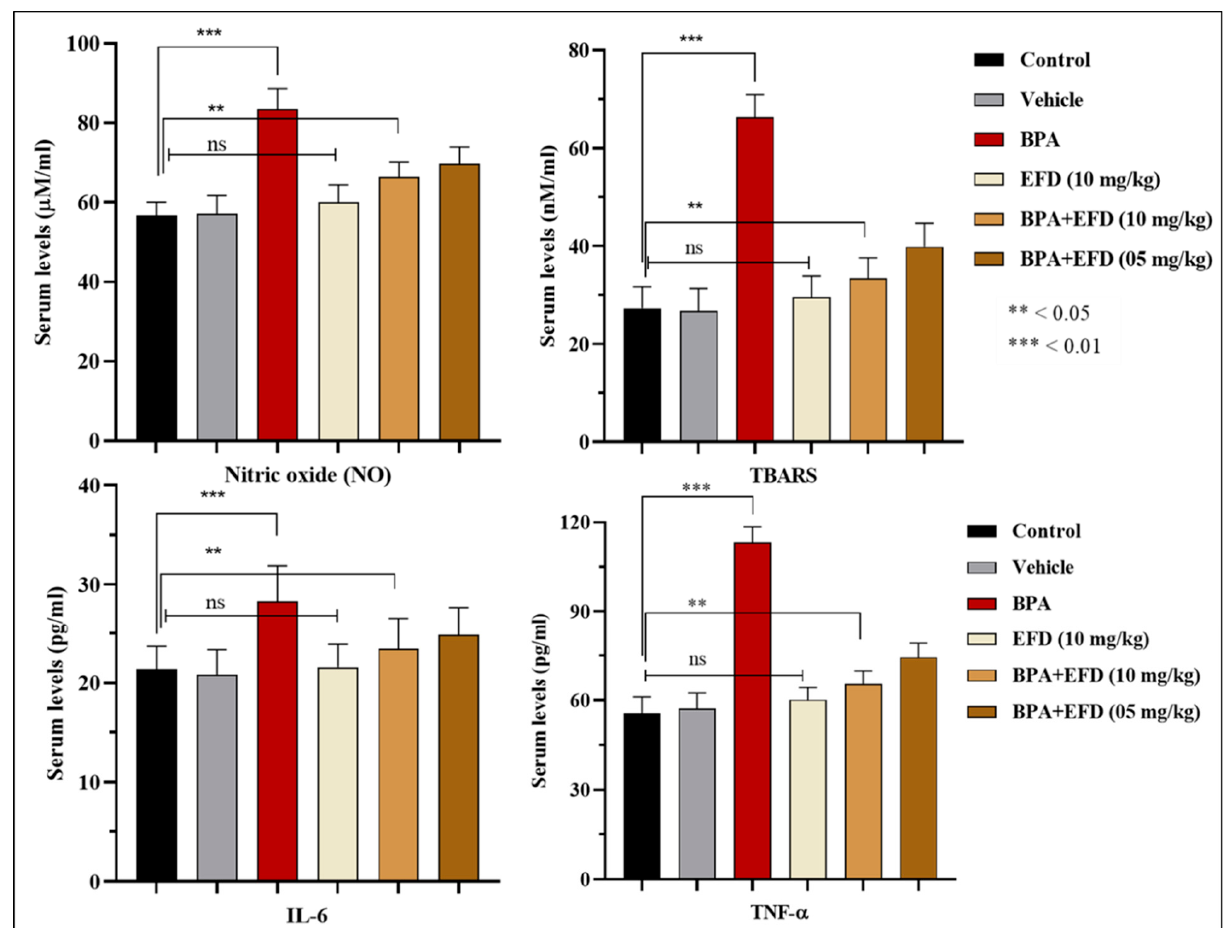
Figure 6. Fate of pro-inflammatory markers in experimental animals after co-treatment with EFD (05 and 10 mg/kg). (NO) Nitric oxide, (TBARS) Thiobarbituric acid reducing substances (Lipid peroxidation assay), (IL-6) Interleukin-6, (TNF- α ) Tumor necrosis factor alpha. Data is presented as mean ± SD ( n = 7). Differences in serum levels were considered significant at the level of ** p < 0.05 and *** p < 0.01.